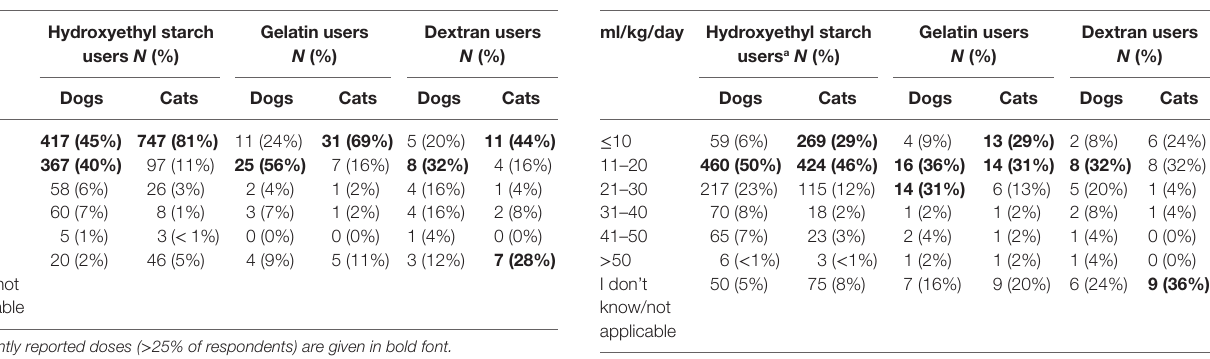
TaBle 2 | Maximum daily dose of synthetic colloids used for fluid resuscitation by survey respondents.